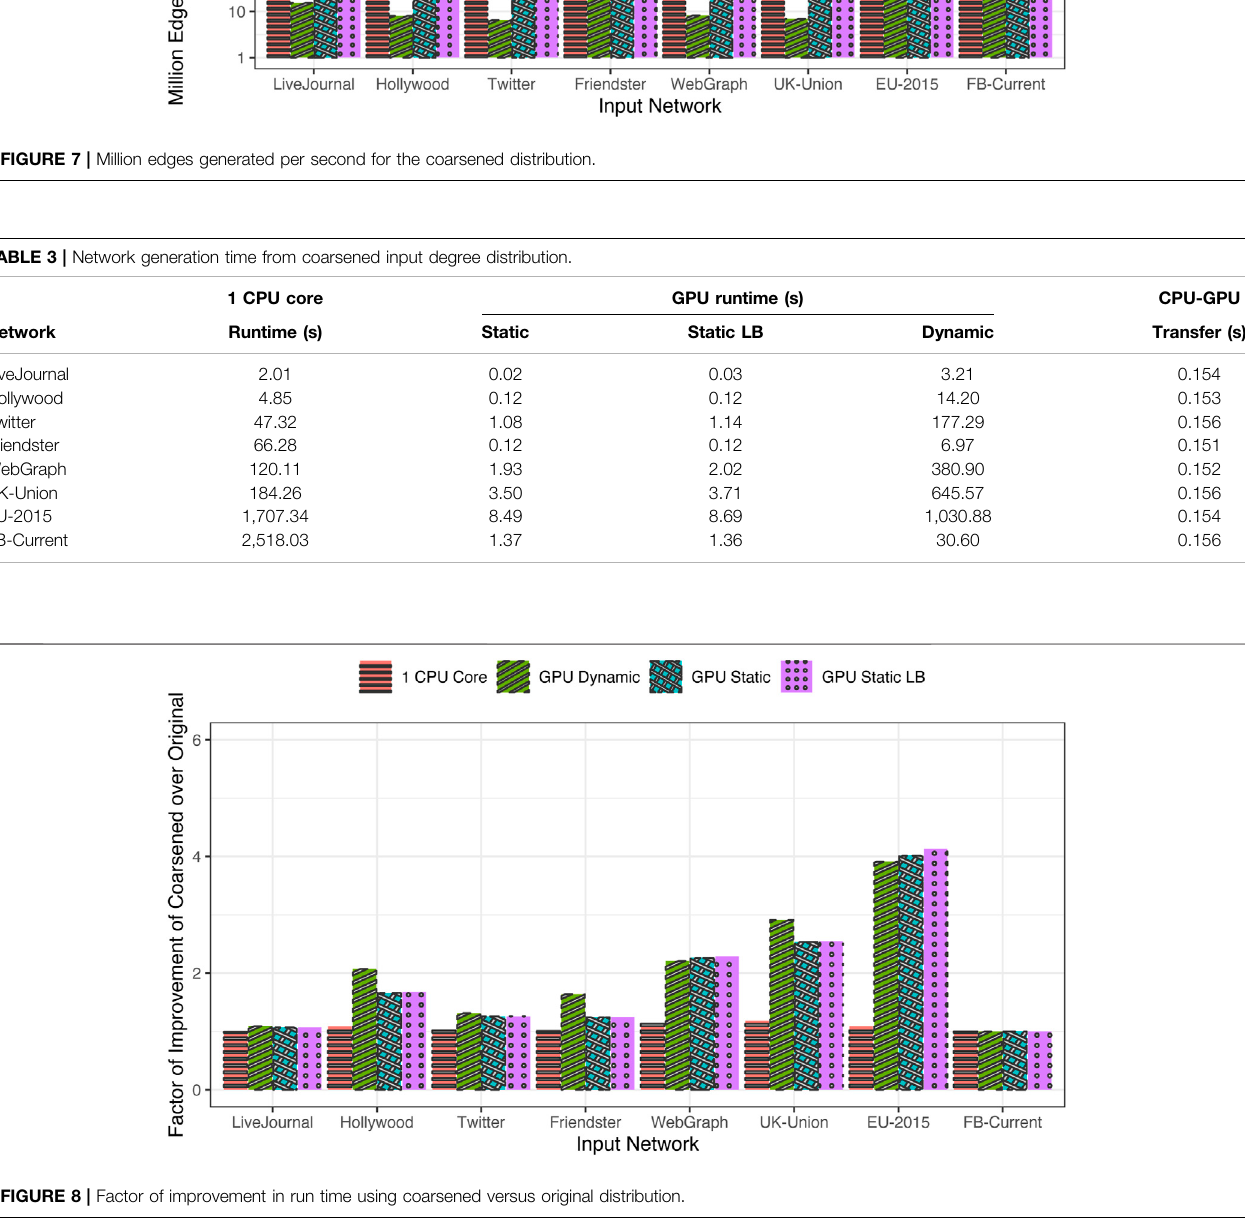
Frontiers in Big Data |